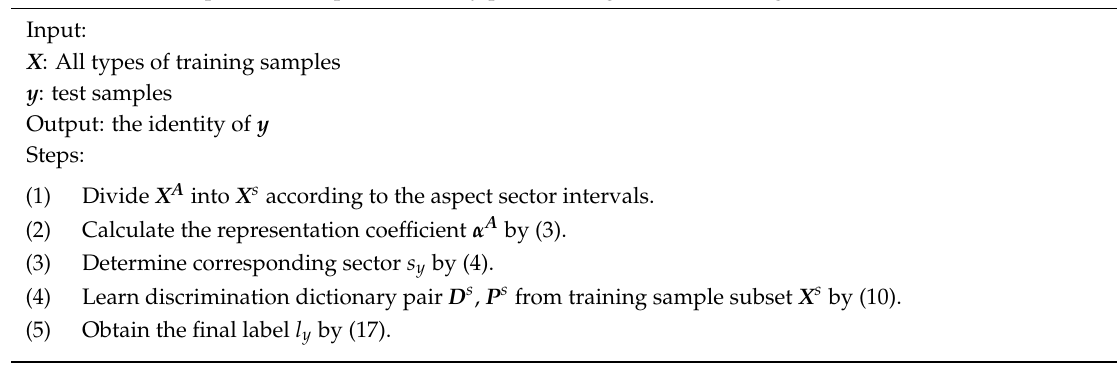
Algorithm 1: Adaptive local aspect dictionary pair learning based SAR image classification